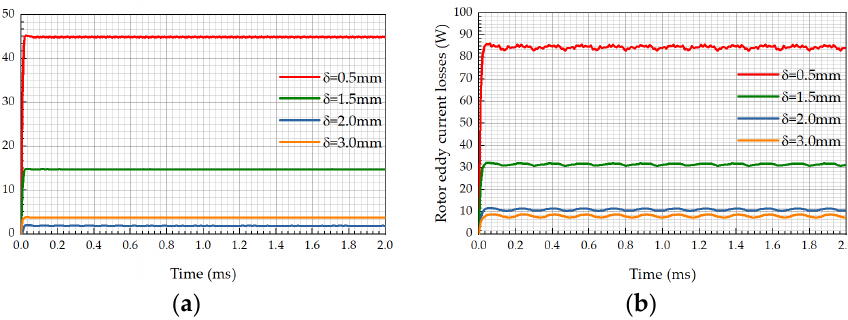
Figure 3. Rotor eddy ‐ current losses on the magnets under no load and rated load: ( a ) no ‐ load; ( b ) rated load.